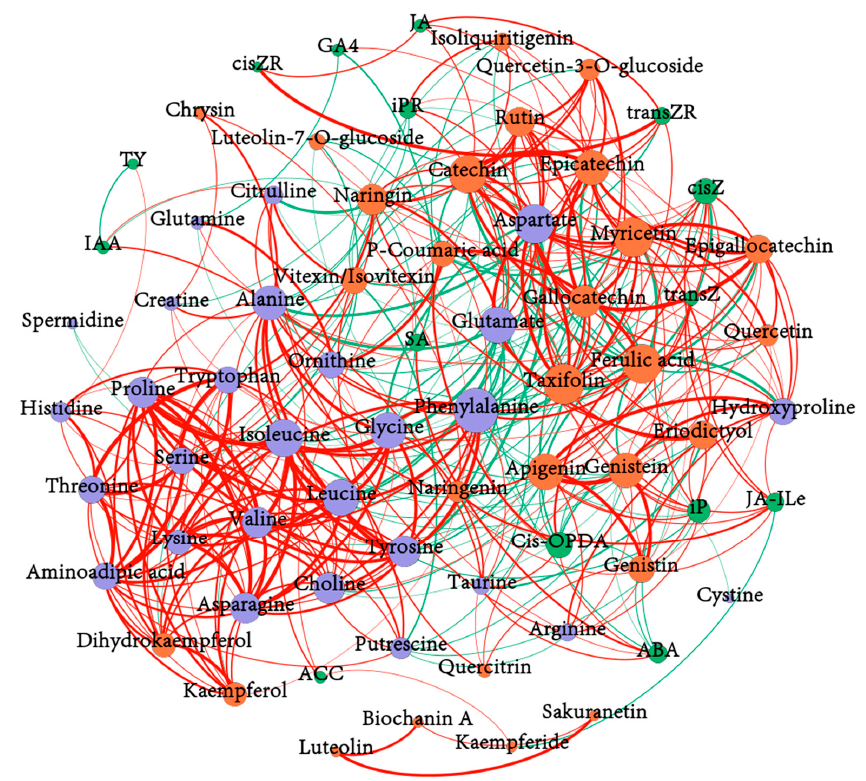
Figure 5. The correlation network analysis among amino acids, flavonoids, and phytohormones. | r | > 0.5, p < 0.05. The colors of the nodes represent the categories of metabolite and the size of nodes relates to the quantity of the corresponding metabolite; the red line means a positive correlation and the green line means a negative correlation. The wider the line, the more significant the correlation .